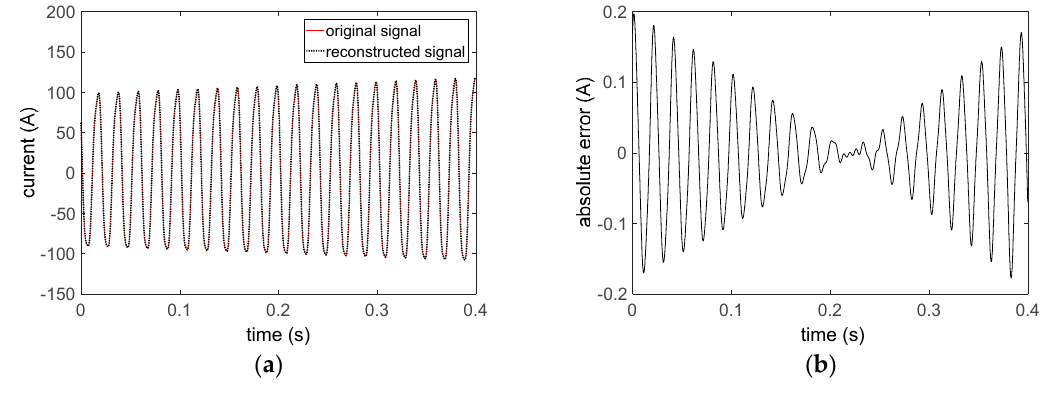
Figure 5. Simulation results of the improved method based on WIFFT and DE algorithm: ( a ) Comparison of the original signal and reconstructed signal; ( b ) Absolute error of original signal and reconstructed signal.